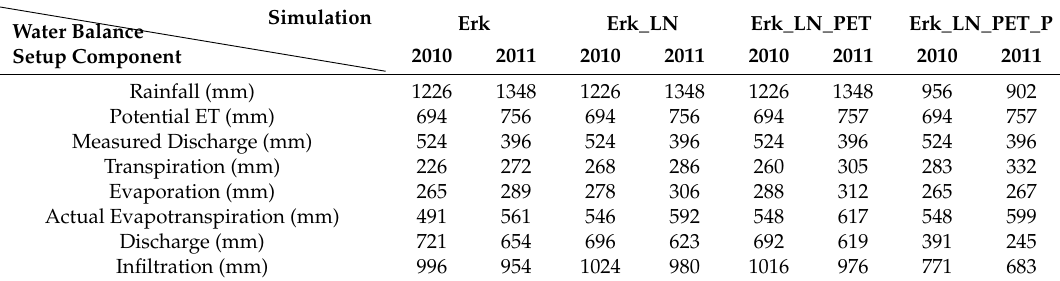
Table 5. Water balance components for simulations of the Erkensruhr